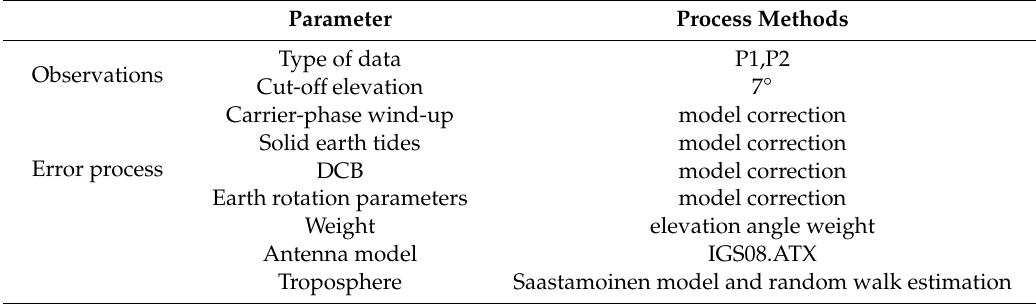
Table 2. The parameters selection methods.